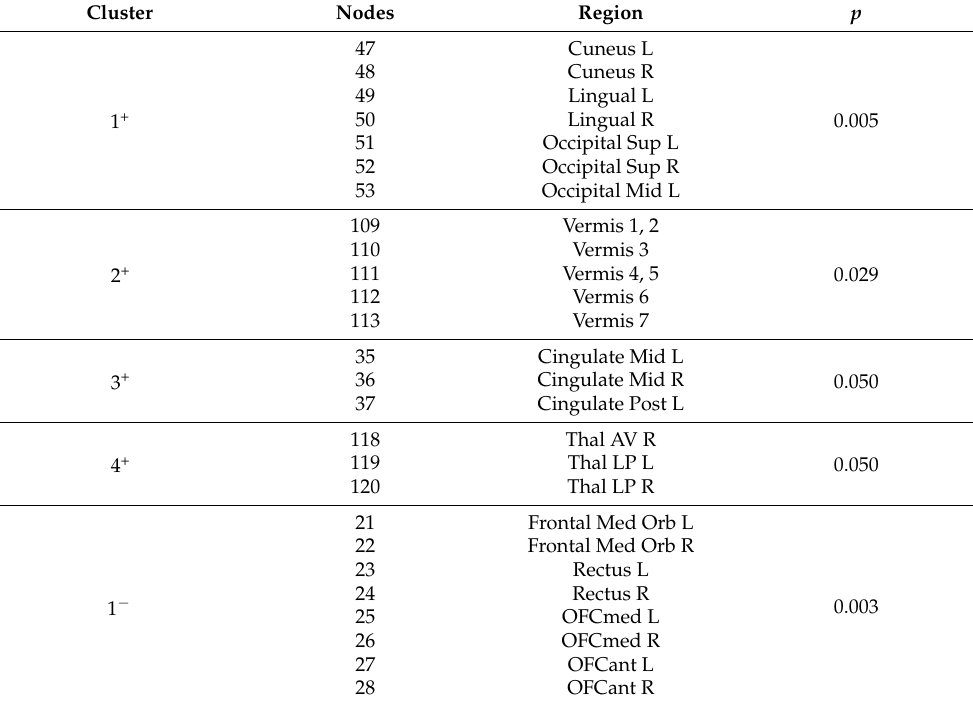
Table 4. Significant clusters for the node strength measure; here, superscripts “+” and “ − ” denote positive (Control > MDE) and negative (MDE > Control) clusters, respectively.